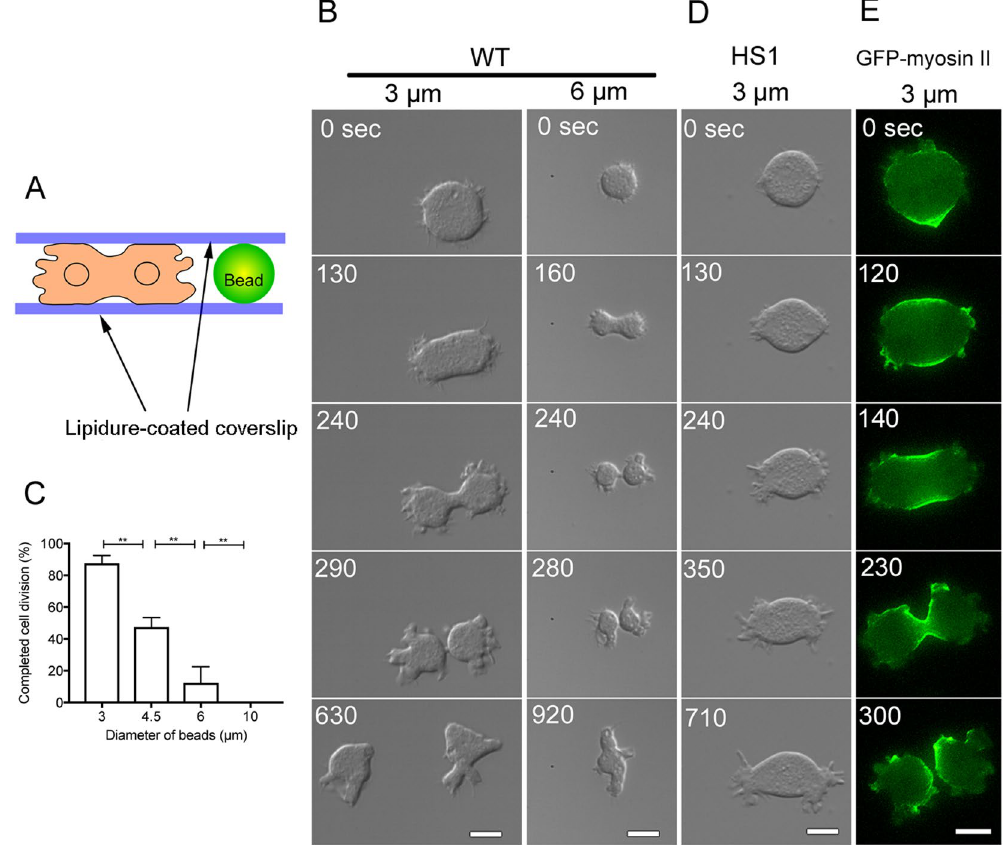
Figure 5. Cells can divide in a confined environment without any specific adhesion. ( A ) Cells were sandwiched between two Lipidure-coated coverslips. To obtain a space with a defined width, polystyrene beads (3, 4.5, 6, or 10 µ m in diameter) were mixed with the cells and placed between two Lipidure-coated coverslips. ( B ) Typical time course of wild-type cell division in spaces with a width of 3 µ m and 6 µ m. In a 3- µ m-wide space, the cell completed cytokinesis (left column), whereas the cells failed in a space with a width of 6 µ m (right column). ( C ) A summary of the frequency of successfully completed cell division in space with various widths (beads sizes) between the two coverslips. Data are presented as mean ± SD in three independent experiments (n = 20 cells, each). ** P ≤ 0.001; ns, not significant, P > 0.05. ( D ) Typical time course of failure of a myosin II-null cell in a space with a width of 3 µ m. ( E ) Typical time course of myosin II-null cells expressing GFP-myosin II in a space with a 3- µ m width between the two coverslips. Note that myosin II accumulated at the cleavage furrow during cytokinesis. Bars, 10 µ